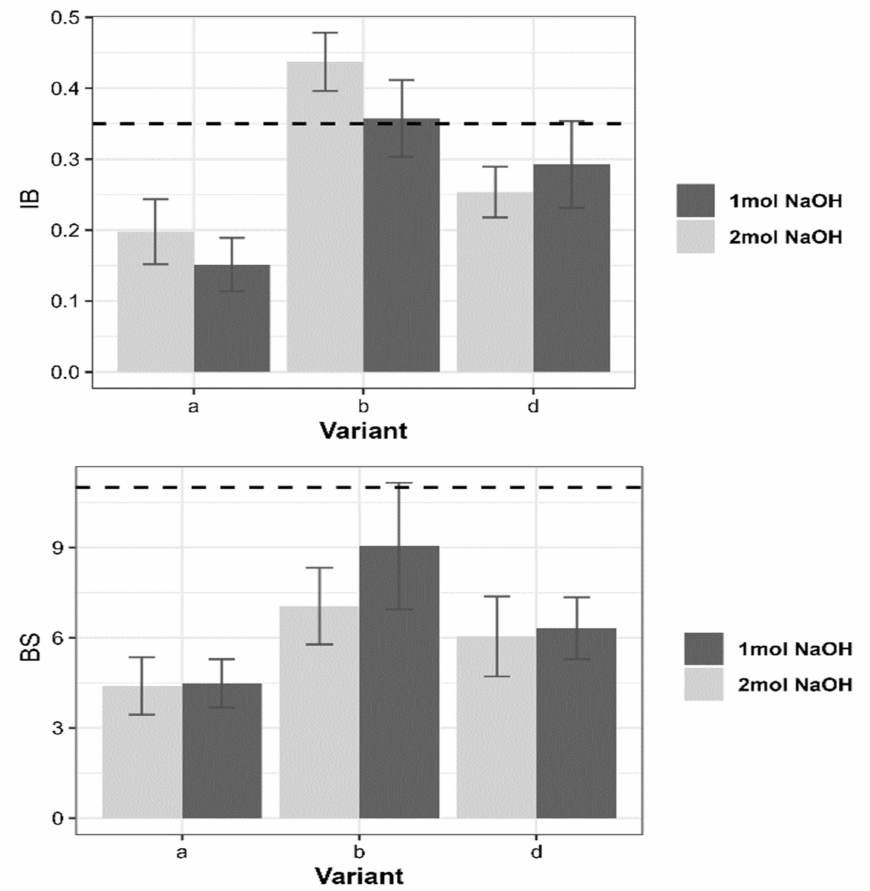
Figure 4. IB and BS of particleboards bonded with canola meal-based